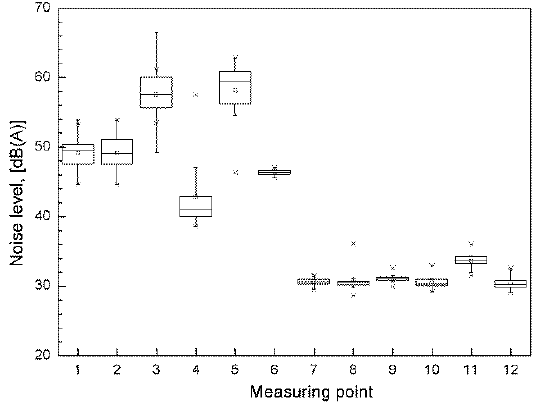
Figure 14. Basic measurements.